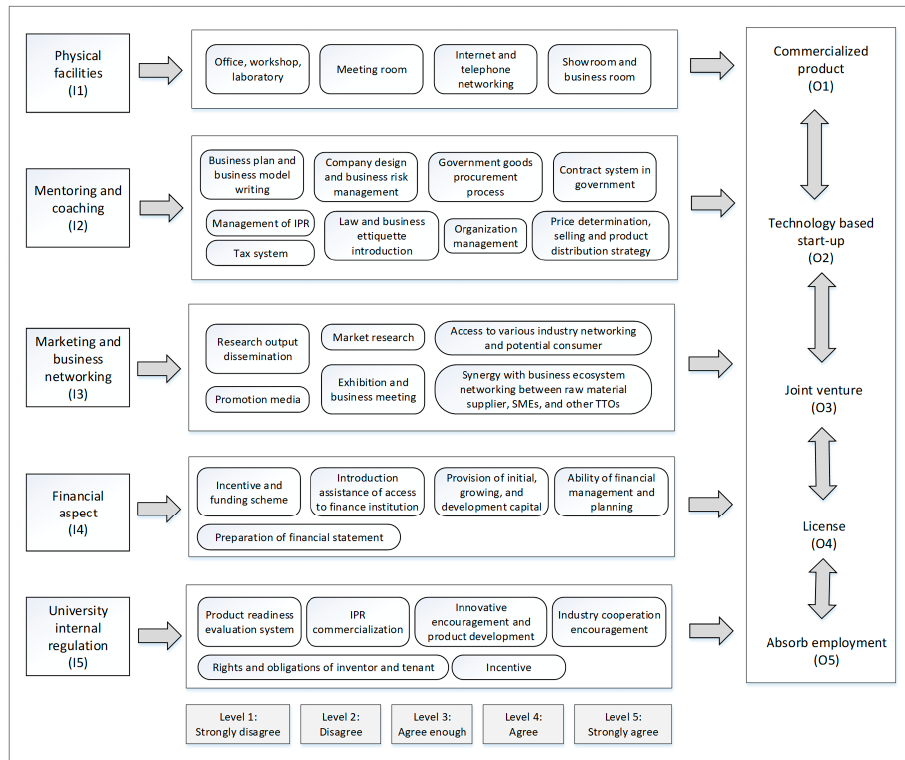
Figure 3. Commercialization strategy framework.